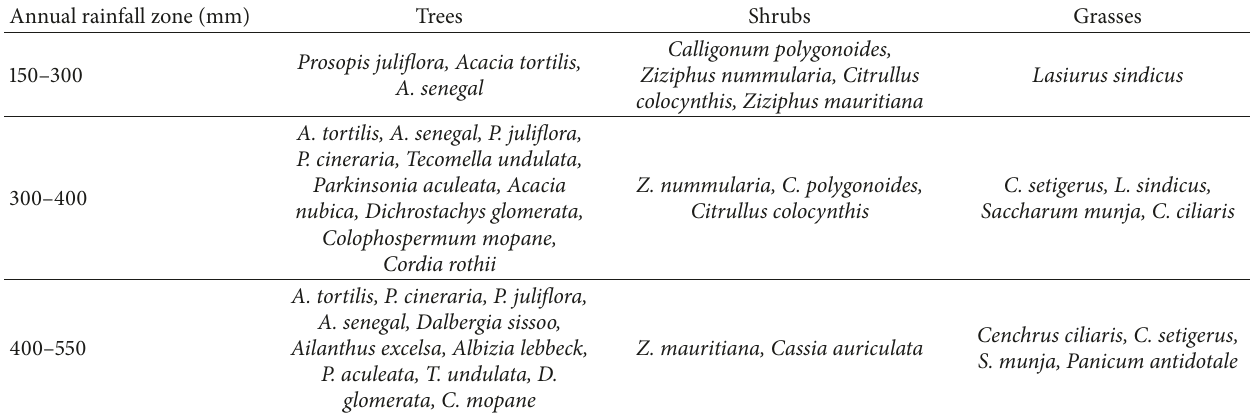
Table 2: Plant species suitable for aeolian sand